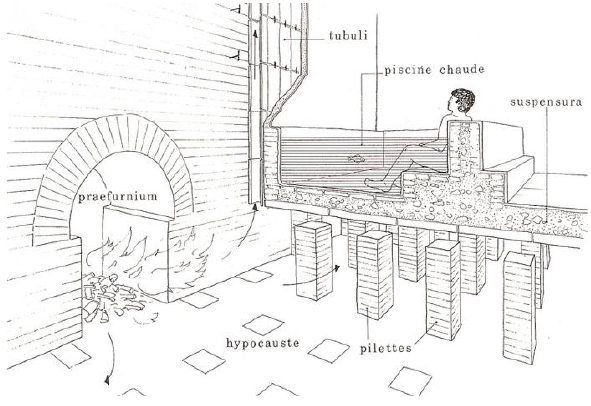
Figure 11. Functioning of the heating system of Pompeii Thermal